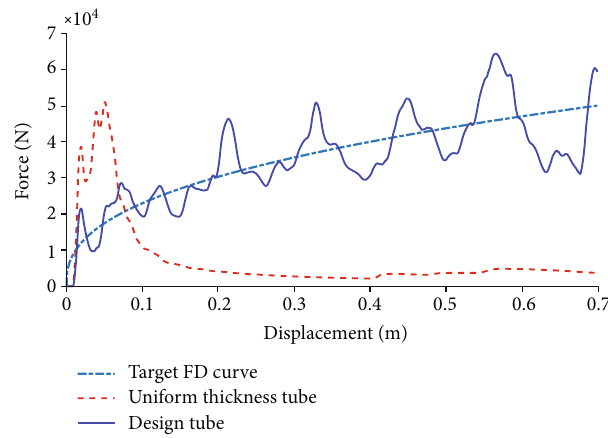
Figure 23: The FD curve of the uniform thickness tube and designed tube.